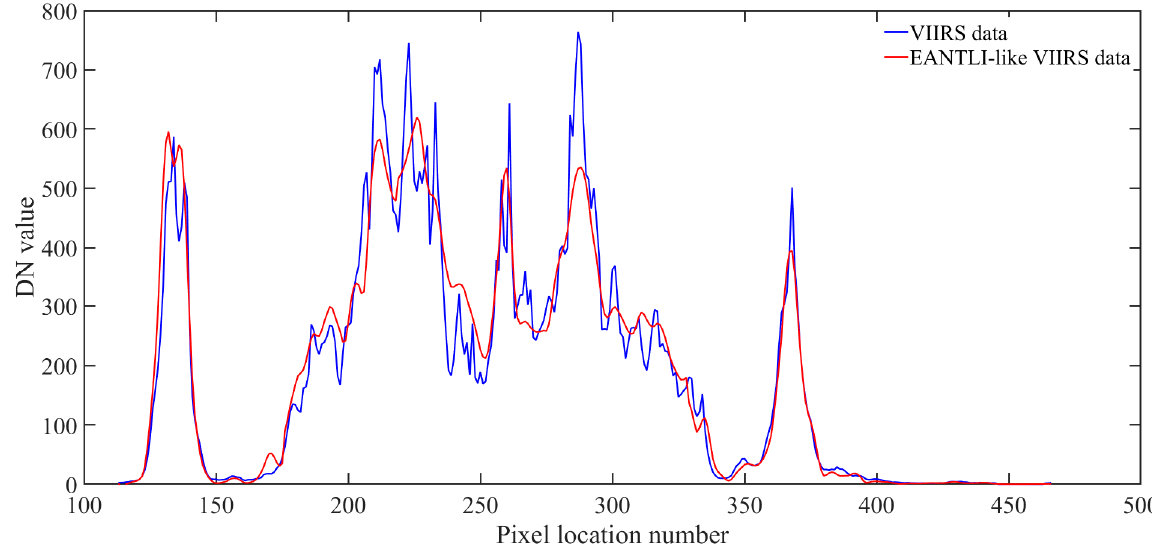
Figure 6. DN values of VIIRS data and EANTLI-like VIIRS data along the latitudinal transect.